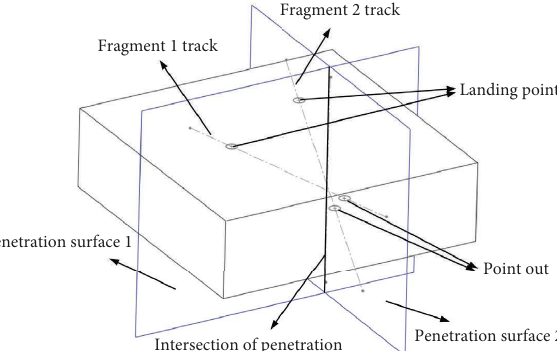
9: Schematic diagram of the assumption that joint damage occurs in the intersection area of the penetration